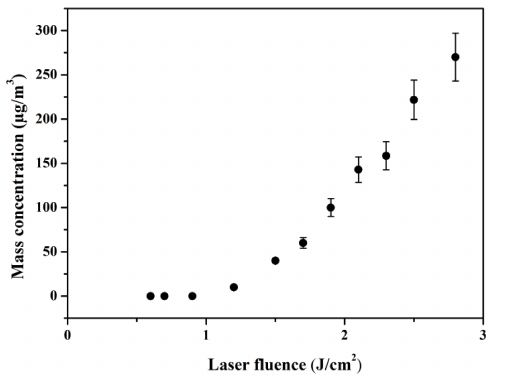
Figure 2. Mass concentration of ablation-generated carbonaceous aerosol particles as a function of the fluence of the KrF excimer laser. The error bar represents the standard deviation of the mea- sured data including concentration and instrument instability.